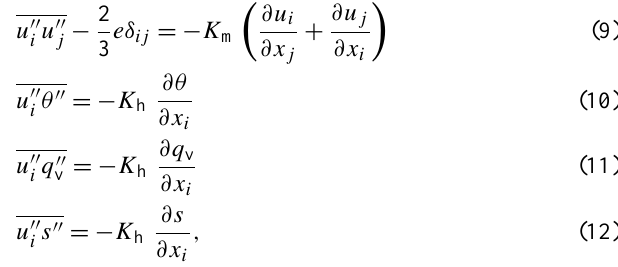
Angular velocity of the